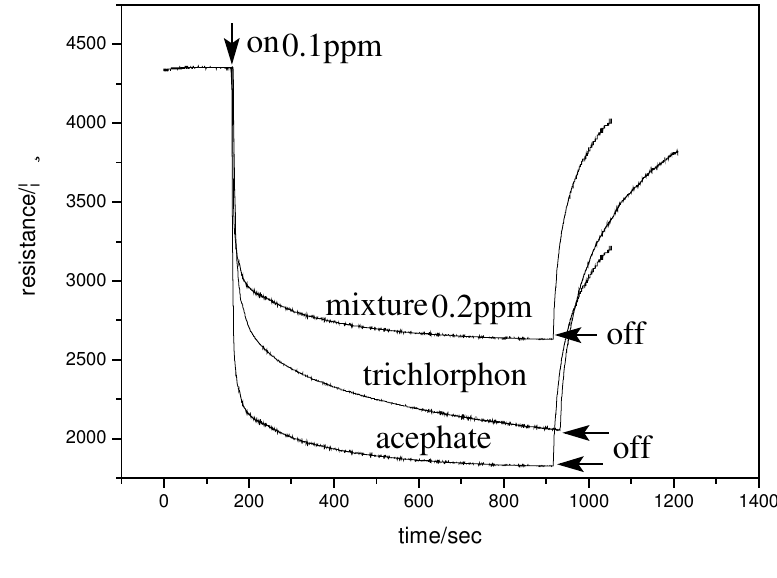
Figure 1. Static response characteristics of the sensor to trichlorphon , acephate and mixture gas atmosphere (operating temperature: 300 o